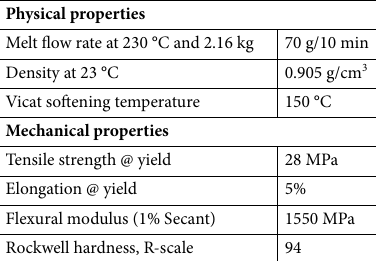
Table 2. Mechanical and physical properties of the matrix-polypropylene (PP).